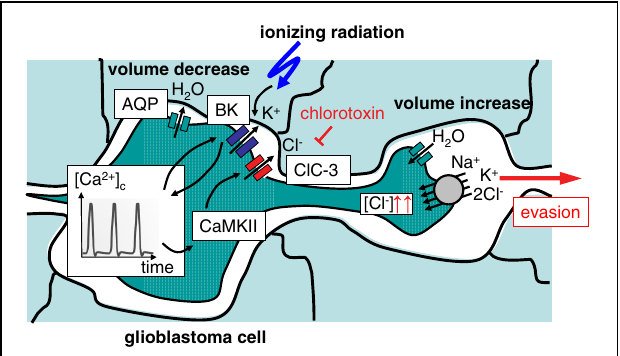
FIGURE 2 | Ionizing radiation (IR)-induced activation of BK K + channels results in evasion of glioblastoma cells from radiation stress. Activation of BK channels occurs upstream of CaMKII and ClC-3 Cl − channels. The Na + /K + /2Cl − cotransporter accumulates Cl − above its electrochemical equilibrium. Cl − is used as osmolyte for volume